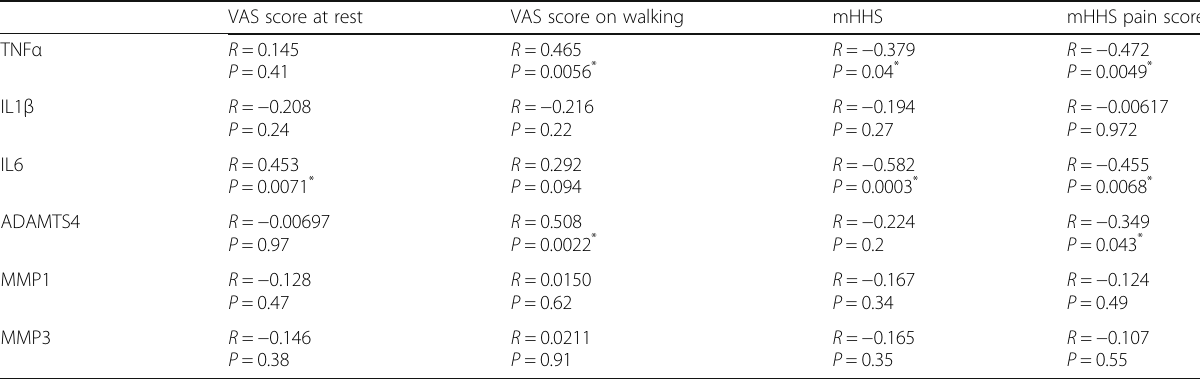
Table 4 Correlations between hip pain, function, and cytokine levels VAS score at rest VAS score on